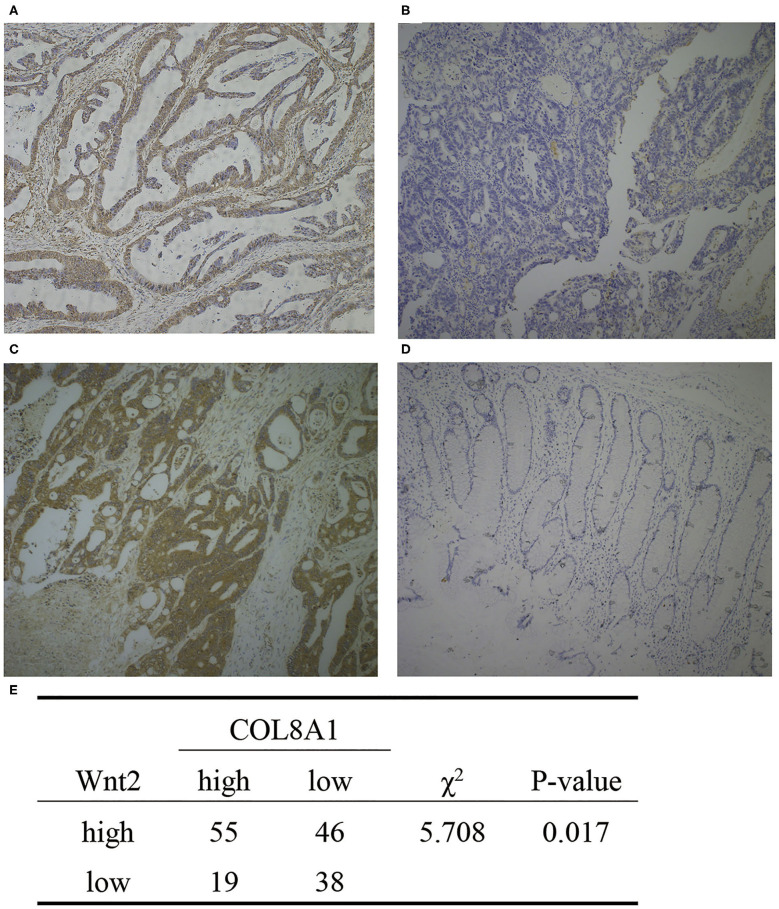
Expression of Wnt2 and COL8A1 in COAD tissues. (A) High expression of Wnt2. (B) Low expression of Wnt2. (C) High expression of COL8A1. (D) Low expression of COL8A1. (E) Analysis of the expression of Wnt2 and COL8A1 in 158 tissue samples. Images are taken at a magnification of 10×.